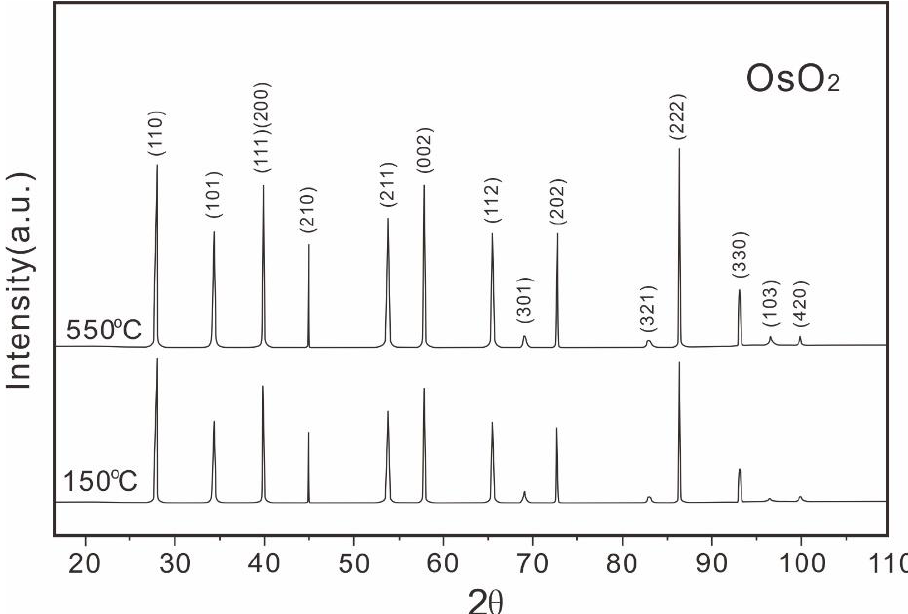
Figure 3. Representative XRD analysis of the OsO 2 crystals at 150 and 550 °C, 24 h, and 100 MPa using 0.005 mol/L initial solutions.